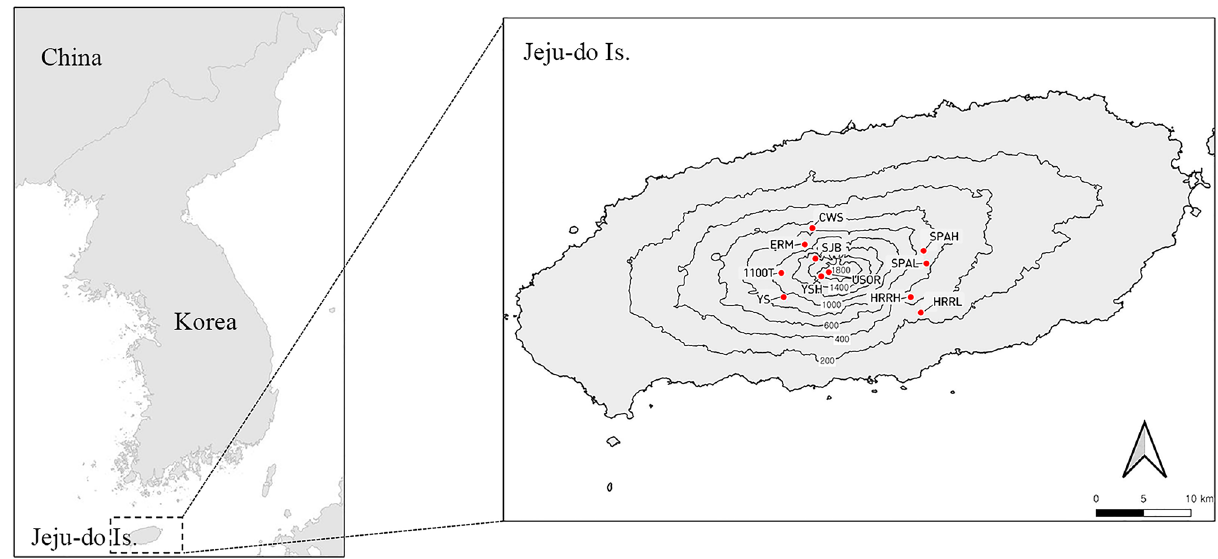
Figure 5. Map of 11 study sites in Mount. Hallasan National Park (HNP), South